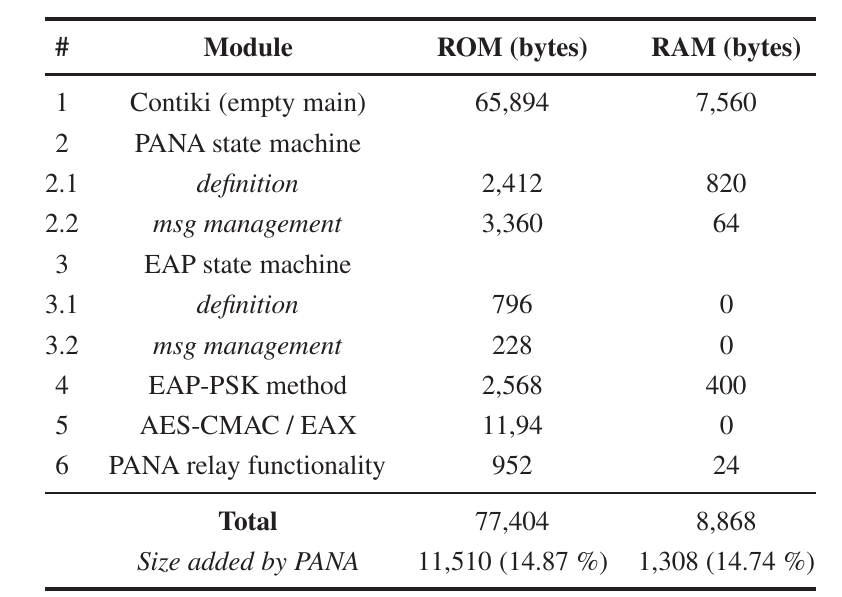
Table 1. Memory sizes. PSK, pre-shared symmetric